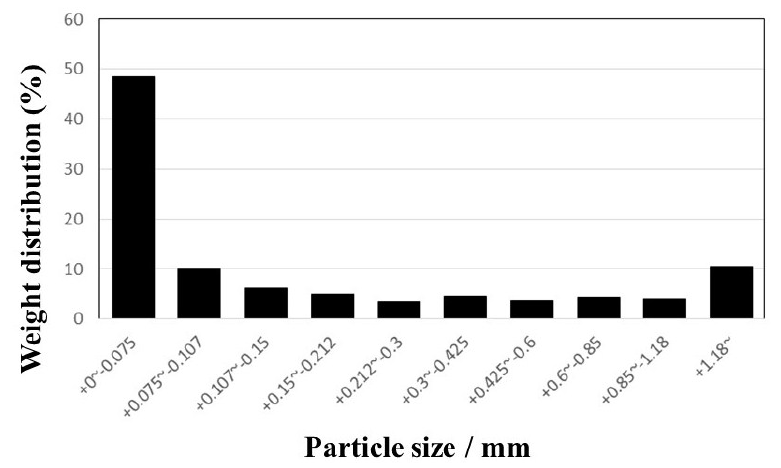
Figure 1. Particle size distribution of the contaminated